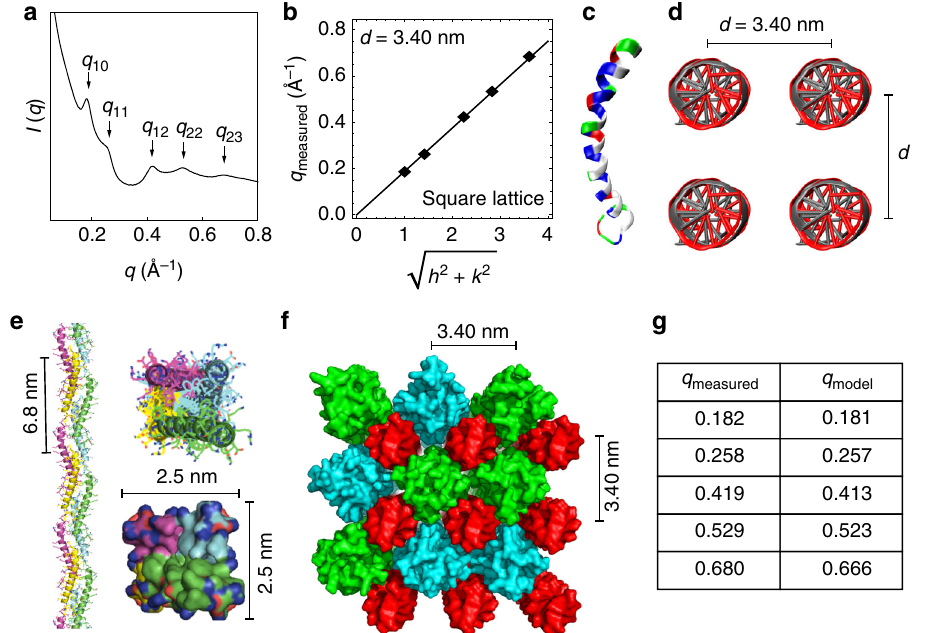
Fig. 3 Structure of LL37-double-stranded DNA (dsDNA) complexes from small-angle X-ray scattering (SAXS) and molecular simulations. a Representative SAXS data from an isoelectric LL37-dsDNA complex. All observed re fl ections are labeled with their respective Miller indices ( hk ). b Two-dimensional ffiffiffiffiffiffiffiffiffiffiffiffiffiffiffi p h 2 þ k 2 square lattice re fl ections ( q hk ) from a are fi tted to q hk ¼ 2 π d , yielding a lattice parameter of d = 3.40 nm ( R 2 = 0.999). c Structure of the LL37 monomer (PDB: 2K6O 59 ). Cationic residues are colored in blue and hydrophobic residues are colored in white. d Schematic of the LL37-dsDNA square columnar lattice with an inter-dsDNA spacing of d = 3.40 nm. The average domain size of the LL37-dsDNA lattice is L ~ 16.1 nm. e Side and top views of the self-assembled LL37 proto fi bril structure formed in the presence of dsDNA. The proto fi bril has rough cross-sectional dimensions of 2.5 nm × 2.5 nm. The helical pitch of the proto fi bril is 6.8 nm per turn. f Top view of a 3 × 3 LL37-dsDNA square lattice from molecular dynamics simulations. Columnar dsDNA is colored red, and the LL37 proto fi bril is colored green (N to C terminus polarity) and teal (C to N terminus polarity). Random polarity of the LL37 proto fi bril is assumed. The inter-dsDNA spacing from the molecular model is 3.4 nm, which agrees with the inter-dsDNA spacing predicted from SAXS. g There is